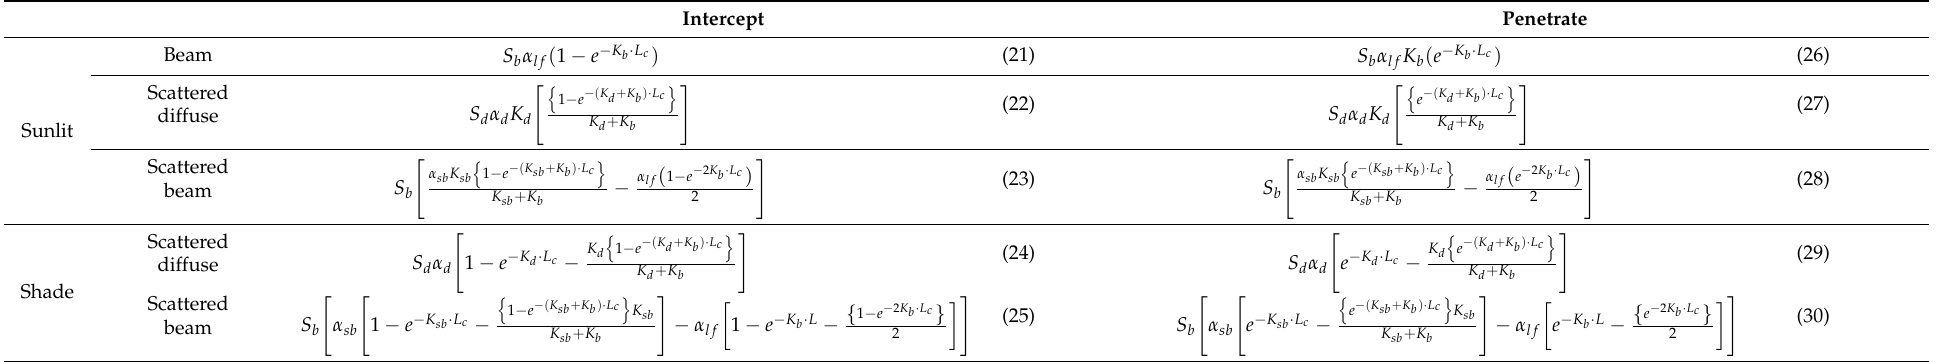
Table 1. Equations of intercepted and penetrated irradiation of sunlit and shaded areas in the canopy for beam, scattered diffuse, and scattered beam